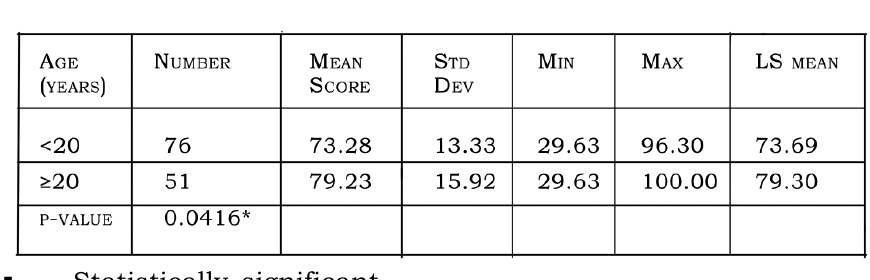
Table 2: Awareness percentage scores by